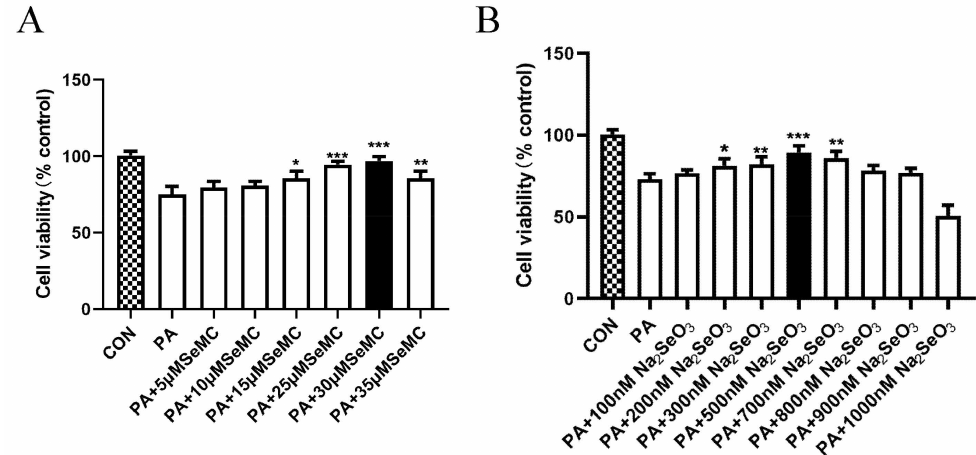
Figure 2. Selection of the best therapeutic concentration of Na 2 SeO 3 and L-SeMC in PA-induced AML-12 cells. ( A ) Cell viability of AML-12 cells was measured by CCK-8 after co-treatment with 300 µ M PA and different concentrations of L-SeMC (0–35 µ M) for 24 h ( n = 7, *** p < 0.001, ** p < 0.01, * p < 0.05 vs. PA group). ( B ) Cell viability of AML-12 cells was measured by CCK-8 after co-treatment with 300 µ M PA and different concentrations of Na 2 SeO 3 (0–900 nM) for 24 h ( n = 7, *** p < 0.001, ** p < 0.01, * p < 0.05 vs. PA